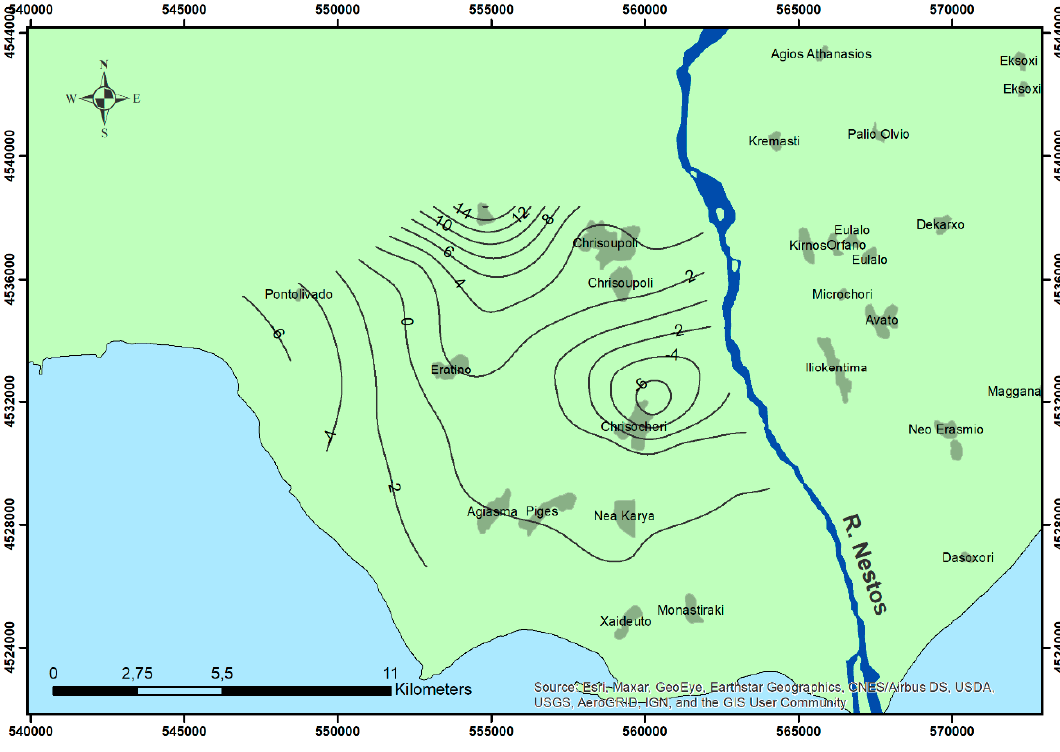
Figure 8. Piezometric map of the confined aquifer (October 2019).